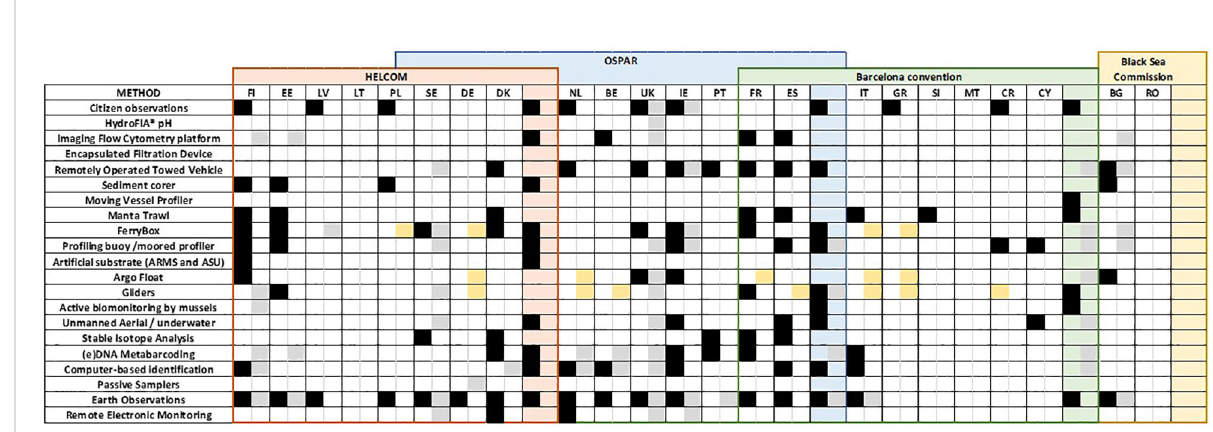
FIGURE 1 The reported use of the novel monitoring methods identi fi ed by Mack et al. (2020) by the EU member states (incl. the UK, an EU member at the time of reporting) and included in the regional sea conventions ’ monitoring programmes (coloured columns). The black cells indicate that the method was reported under the EU MSFD, the grey cells indicate reported plans to include into the EU MSFD (i.e. not yet in use), and the yellow cells indicate use in the EuroGOOS co-operation. The methods are in the same order as in Table 1. Country codes (use of the older 2014 monitoring report is indicated by an asterisk after the country code: FI, Finland; EE, Estonia; LV, Latvia; LT, Lithuania; PL, Poland; SE, Sweden; DE, Germany; DK, Denmark; NL, Netherlands; BE, Belgium; UK, United Kingdom; IE, Ireland; PT*, Portugal; FR*, France; ES, Spain; IT, Italy; GR, Greece; SI, Slovenia; MT*, Malta; CR, Croatia; CY*, Cyprus; BG*, Bulgaria; RO,